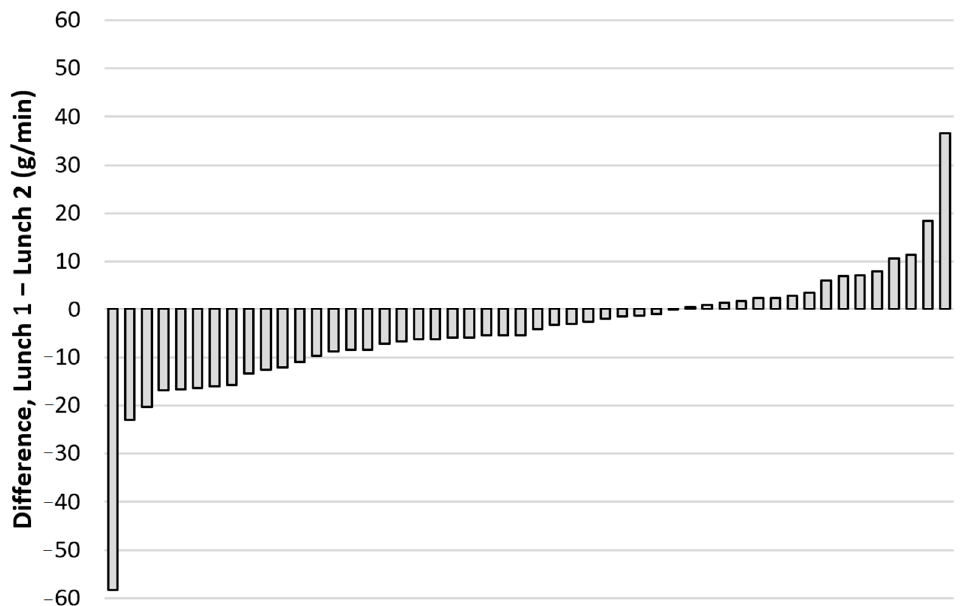
Figure 8. Individual changes in objectively measured eating rate (g/min) between the two repeated school lunches with identical food choices for the same subjects ( n = 50; Lunch 1: December 2015, and lunch 2: February/March 2016).